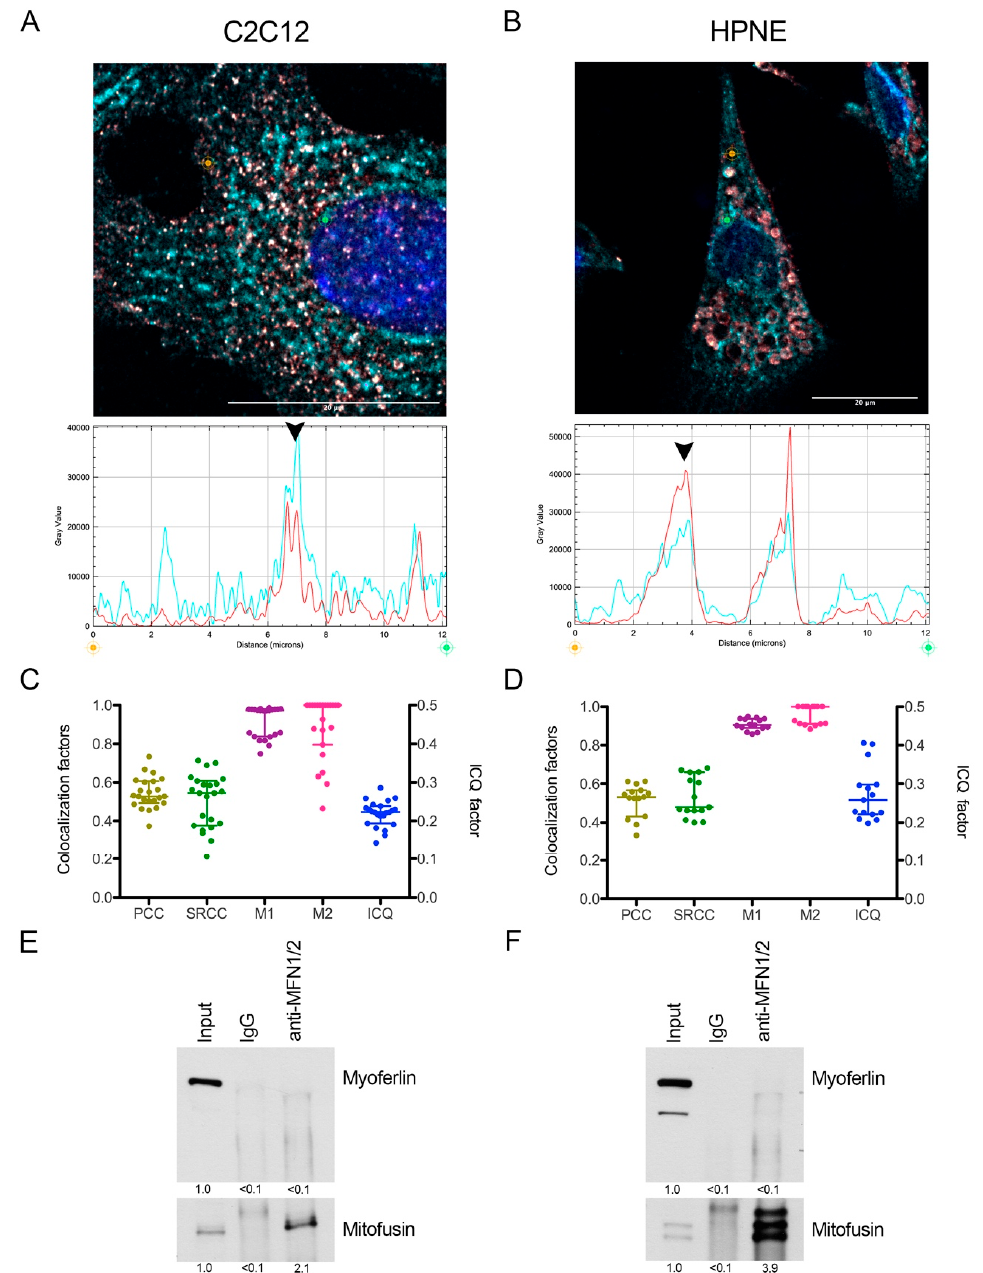
Figure 5. Myoferlin was colocalized with mitofusin-1 in normal cell lines. Representative deconvoluted confocal image of nuclei (blue), myoferlin (HPA—“hot” red scale) and mitofusin-1 / 2 (3C9—“cold” cyan scale) immunofluorescence of ( A ) C2C12 murine myoblast and ( B ) immortalized human pancreatic normal epithelial (HPNE) cell lines. Scale bar = 20 µ m. Channel intensity profiles were established following the segment between orange and green cross marks. Black arrow heads indicate colocalization spots. ( C , D ) Pearson (PCC), Spearman rank (SRCC) correlation coe ffi cients, Manders’ colocalization coe ffi cients (M1,M2), and intensity correlation quotient (ICQ) were calculated on > 15 independent microscopic fields; ( E , F ) coimmunoprecipitation of mitofusins and endogenous myoferlin with an anti-mitofusin antibody. Western blot of protein samples from whole cells (input), IgG control immunoprecipitation (IgG), and mitofusins immunoprecipitation (anti-MFN1 / 2) of C2C12 and HPNE cell lines. Myoferlin and mitofusins were detected on the same membrane. Quantification was performed using ImageJ. All experiments were performed as three independent biological